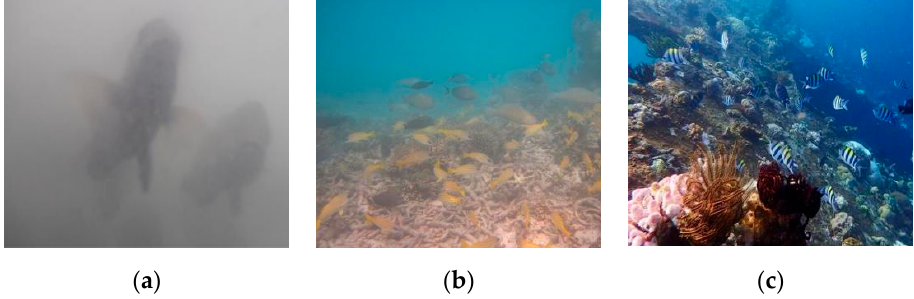
Figure 2. Underwater images of turbid water. ( a ) An underwater photo of a fish farm. ( b ) An un- derwater image of shallow water. ( c ) An underwater image of deep sea.